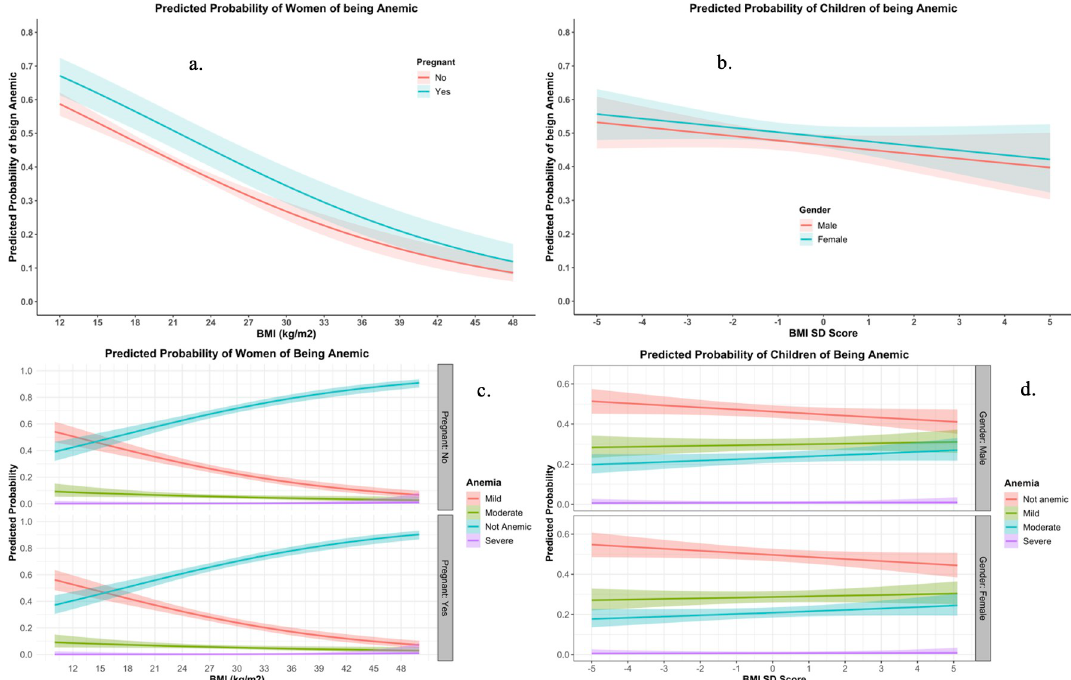
Fig 7. Predicted Probability of Anemia of women (Fig a., c.) and Children (Fig b., d.) from Binary Logistic (Fig a. b.) and Ordinal Logistic regression (Fig c., d.). All of the models were adjusted for Age, Pregnancy, Gender and Wealth Index.